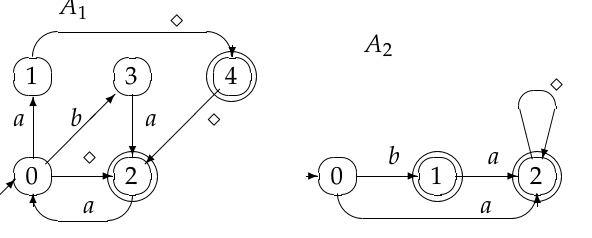
Figure 2. Automaton A 1 , left, and automaton A 2 , right. L ( A 1 ) is a cover language for the σ -minimal partial language for L , and L ( A 2 ) is a cover partial automaton for L , where L = { a , b , aa , ab , ba , aaa , aab , aba , abb , baa , bab }